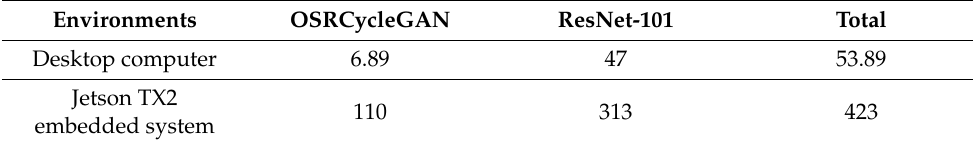
Table 12. Average processing time of one image by the proposed method (unit: ms).